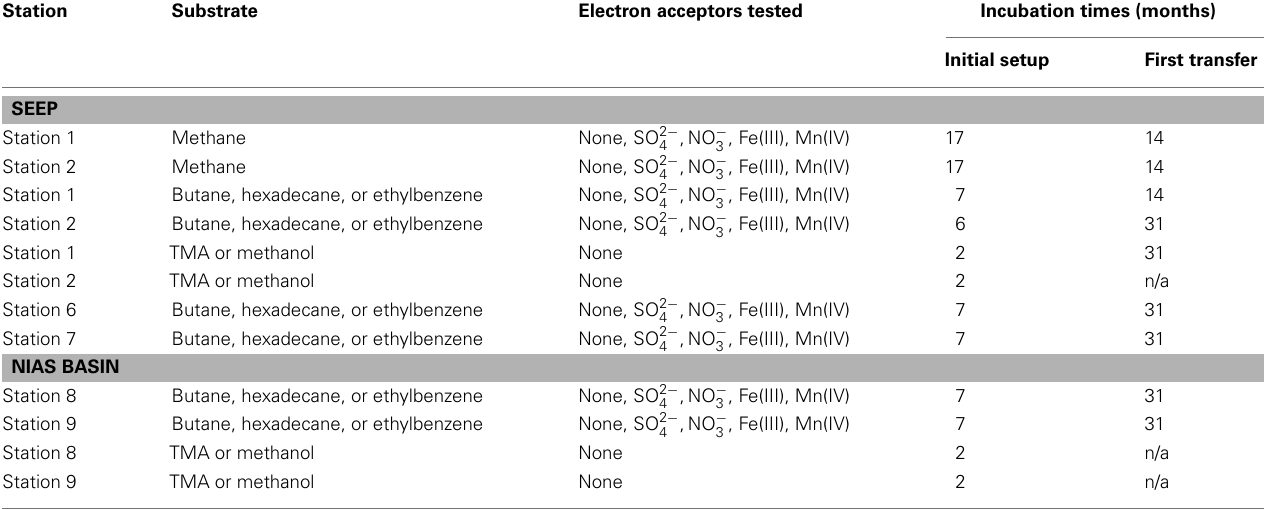
Table 2 | Incubation scheme of initial microcosm setups and of subsequent